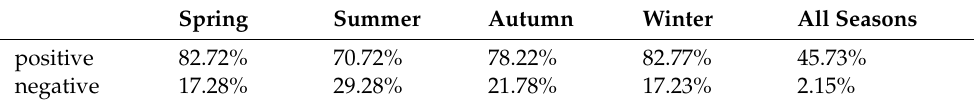
Table 2. Percentages of positive and negative values for the four seasons and all seasons. Spring Summer Autumn positive